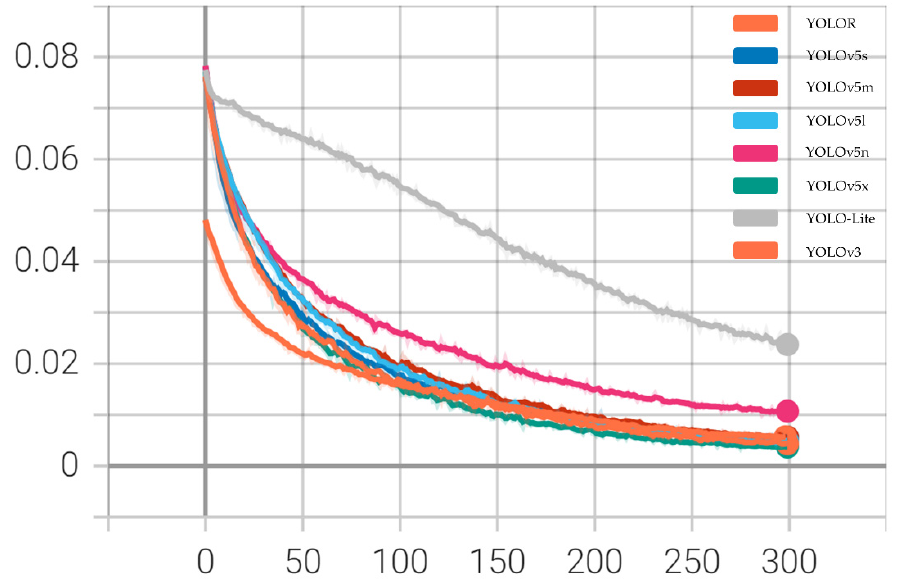
Figure 8. Training loss of eight different architectures. Training loss is computed by summing loss with bounding box regression.